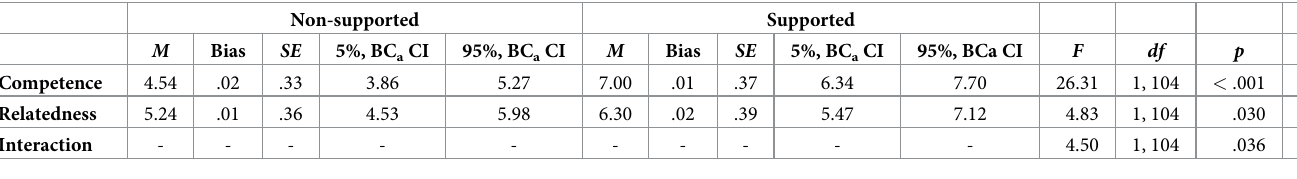
Table 1. Two-way between-subjects bootstrapped ANOVA for task performance level in Study 1.